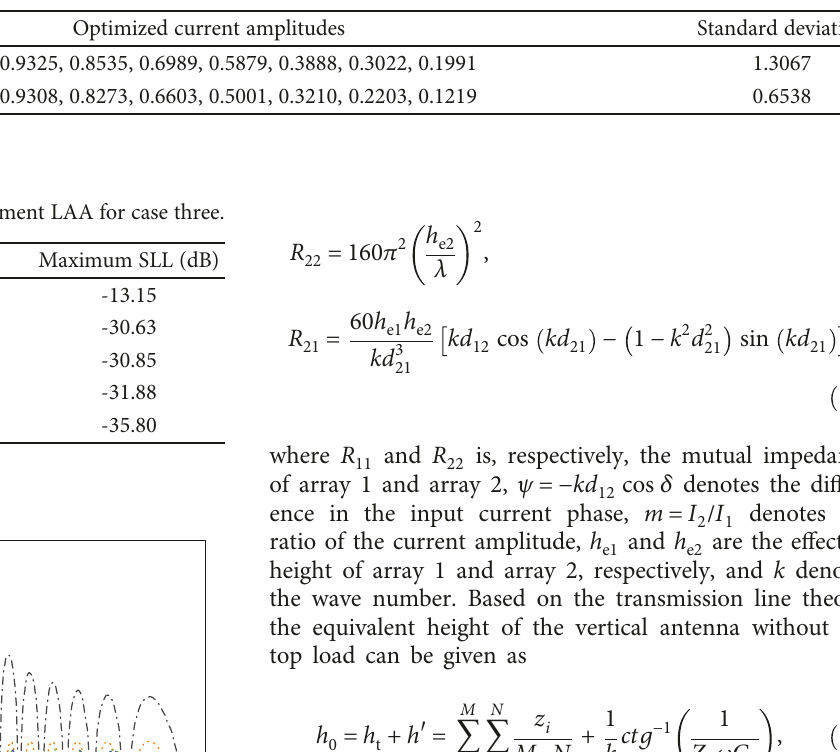
Table 6: The optimized results of the 16-element LAA for case three.